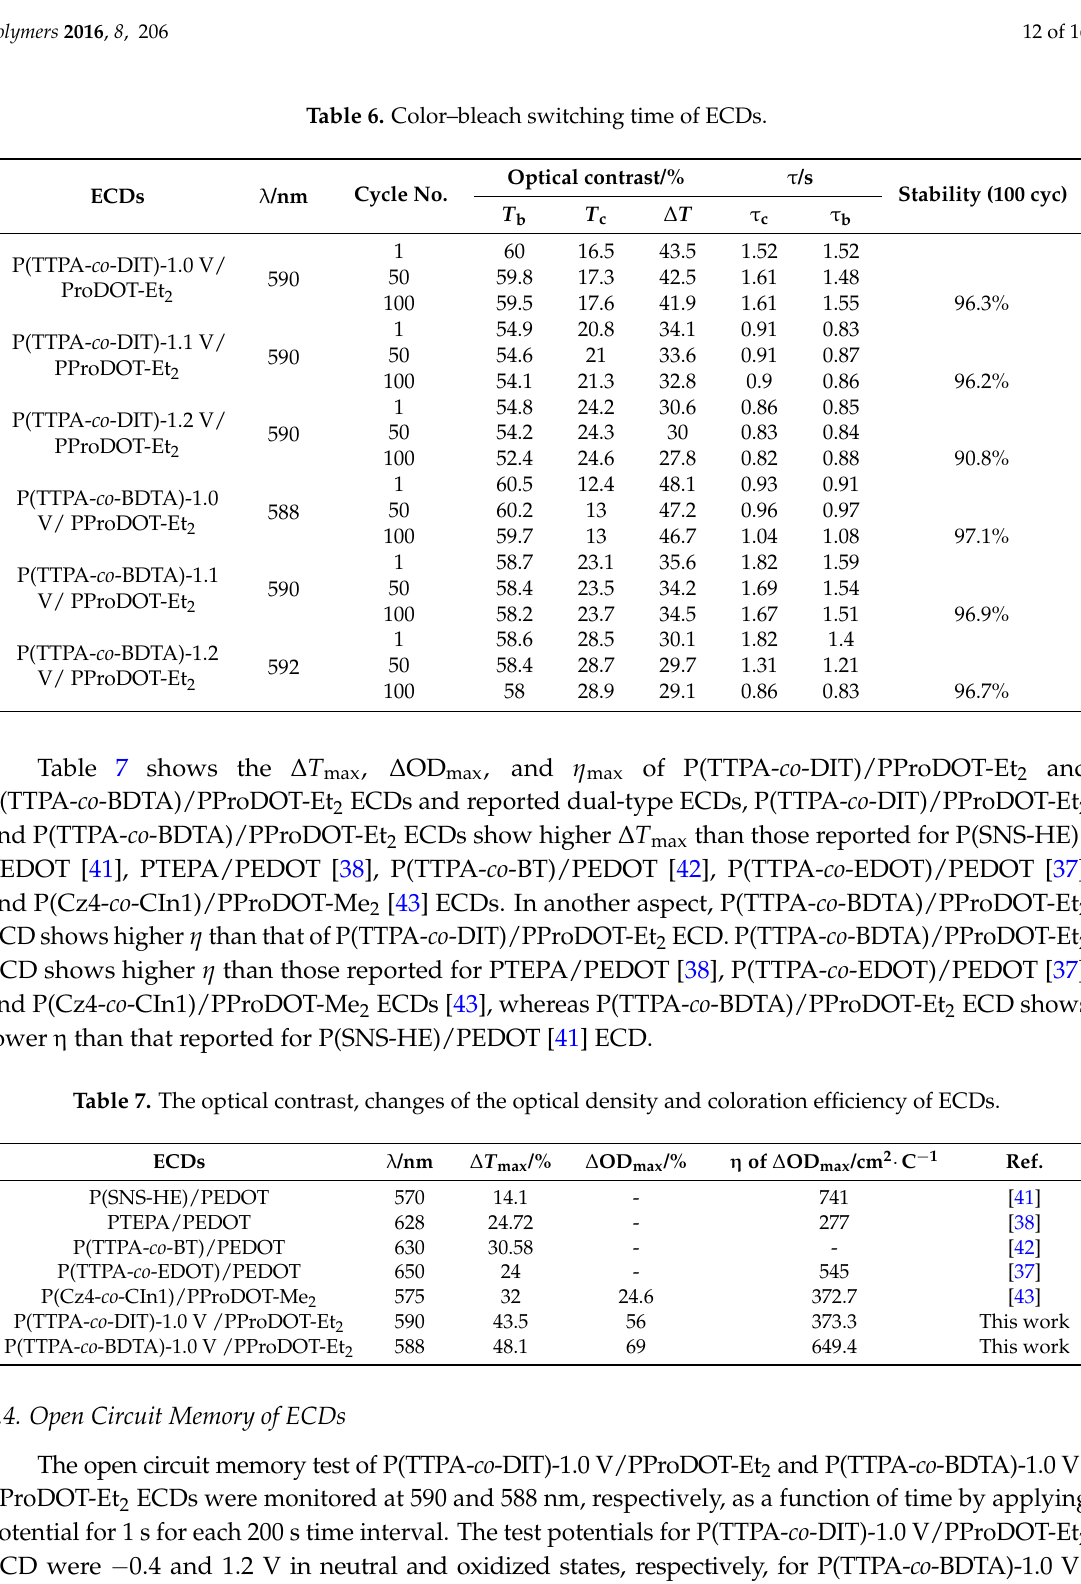
potential for 1 s for each 200 s time interval. The test potentials for P(TTPA- co -DIT)-1.0 V/PProDOT-Et 2 ECD were ´ 0.4 and 1.2 V in neutral and oxidized states, respectively, for P(TTPA- co -BDTA)-1.0 V/ PProDOT-Et 2 ECD were ´ 0.2 and 1.2 V in neutral and oxidized states, respectively. It can be seen in Figure 10a,b that these ECDs show less than 5% transmittance change in oxidized state and less than 2% transmittance change in neutral state, indicating the presence of good optical memories for the